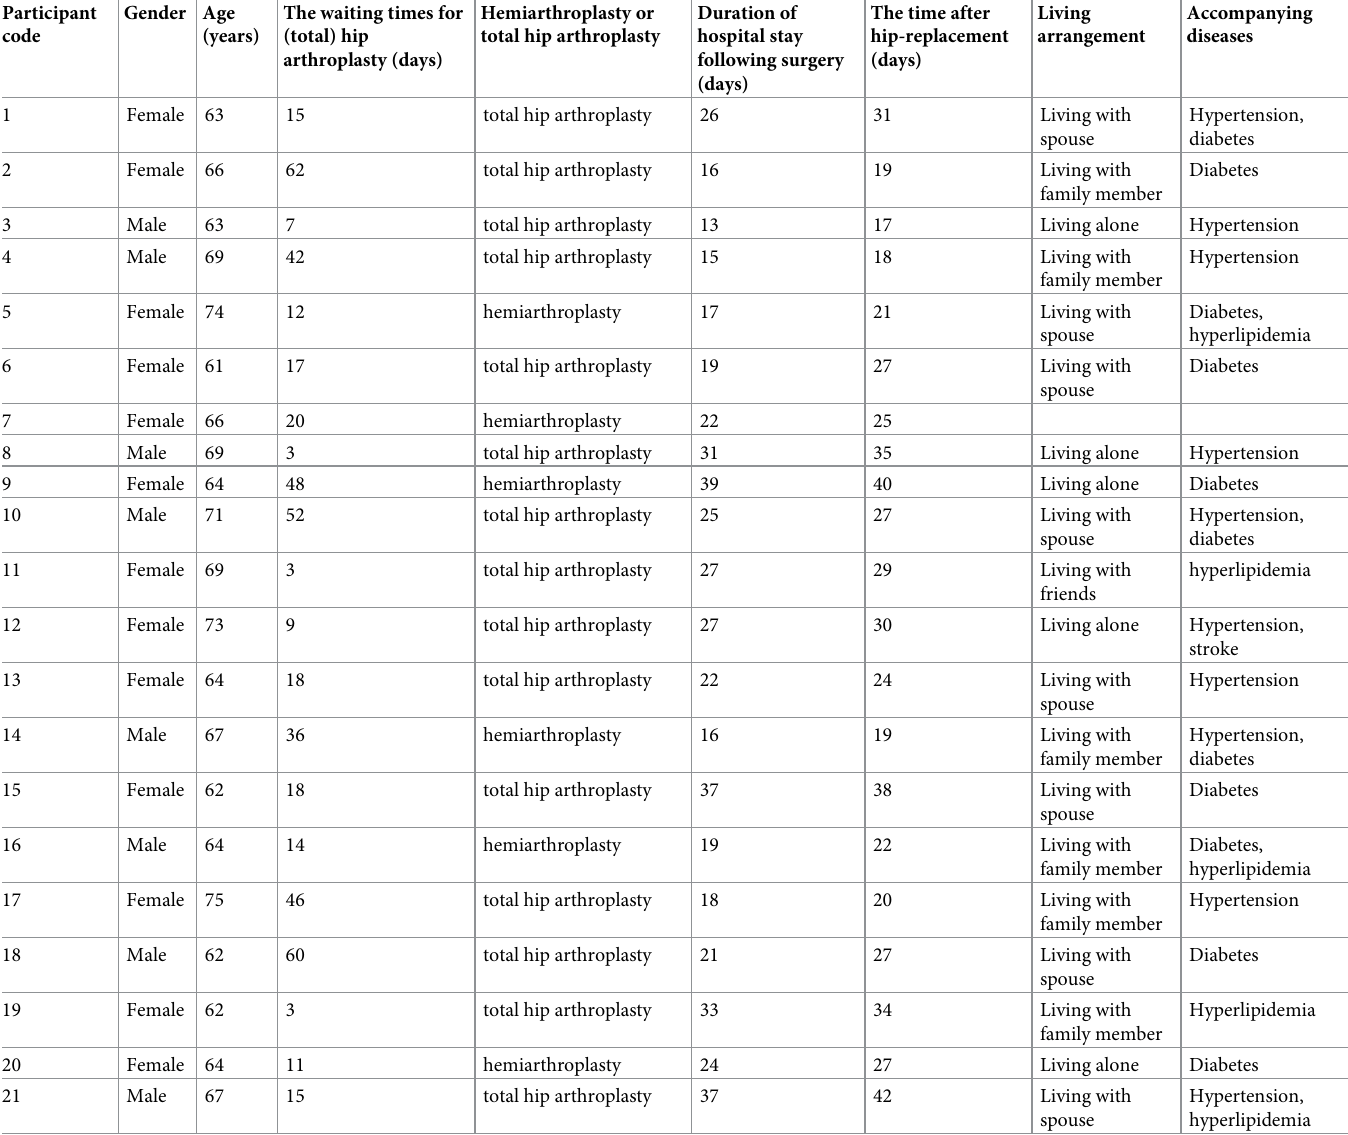
Table 2. The demographic characteristics of interviewed participants. Participant